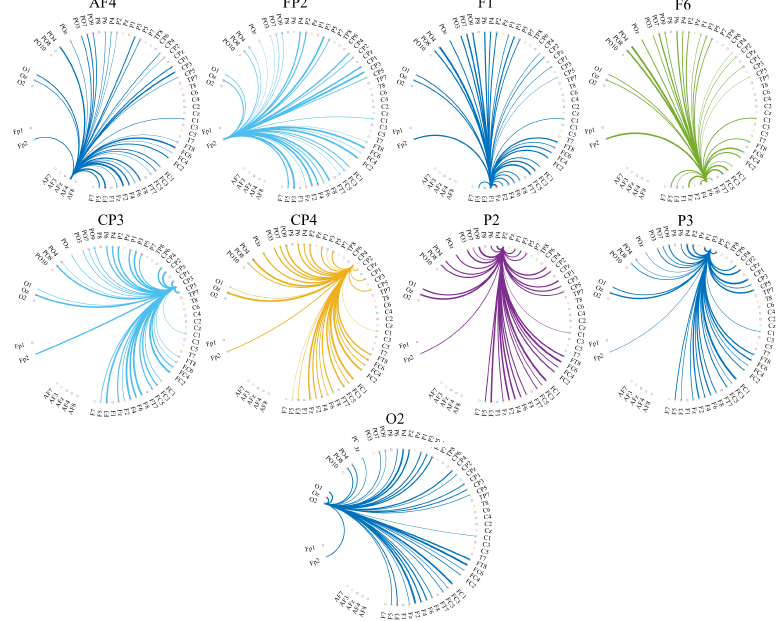
Figure 7. Eyes-Closed (EC) setting. Transfer of information from (i.e., out-degree) FP2, AF4, F1, F6, CP3, CP4, P2, P3, and O2 to the other cortical regions in the case of LOW stress-susceptible group. In each subplot, the source of information transfer (e.g., FP2, AF4, etc.) is the one from which all connections are originated. They are labeled at the top of each subplot. The recipients of information (i.e., channels on the other cortical regions) are the ones at the other end of these outreaching